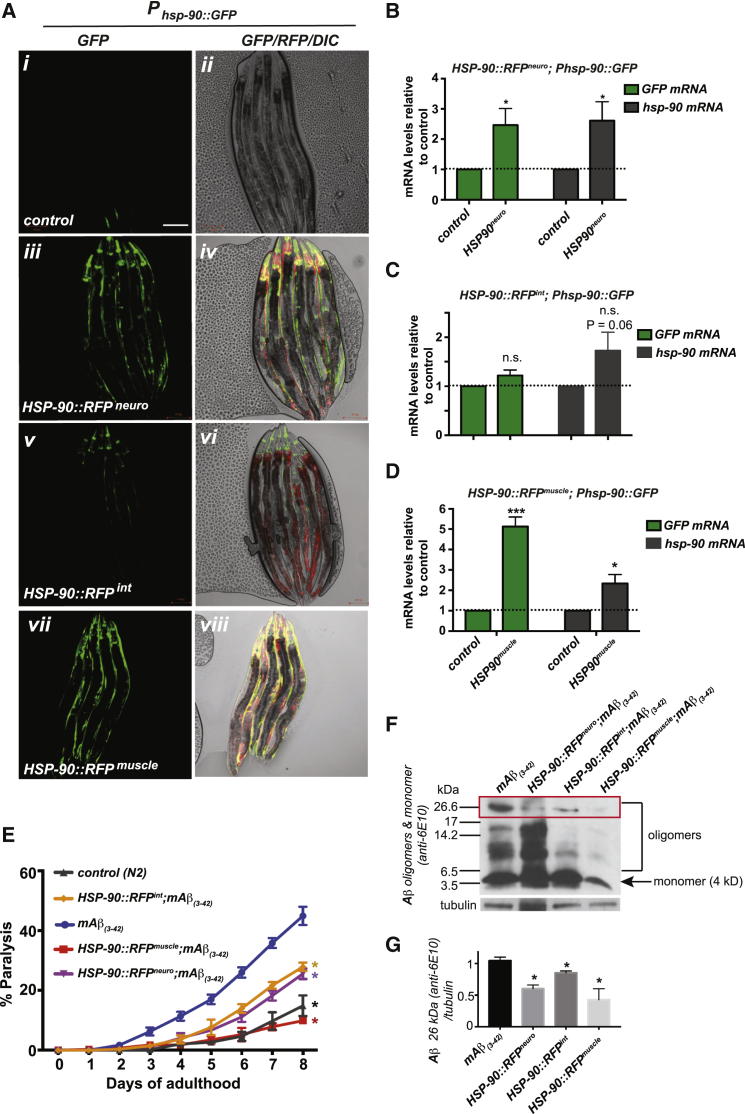
Increased Expression of HSP-90 in the Neurons, Intestine, or Bodywall Muscle Activates TCS and Protects against Aβ(3-42) Protein Toxicity in Muscle(A–D) Phsp-90::GFP expression in control animals (i and ii), HSP-90::RFPneuro (iii and iv), HSP-90::RFPint (v and vi), or HSP-90::RFPmuscle (vii and viii) (A). Scale bar, 50 μm. GFP and hsp-90 mRNA levels in HSP-90::RFPneuro; Phsp-90::GFP (B), HSP-90::RFPint; Phsp-90::GFP (C), and HSP-90::RFPmuscle; Phsp-90::GFP (D) relative to control animals expressing Phsp-90::GFP.(B–D) Bar graphs represent the mean of three independent experiments. Error bars represent ± SEM. ∗p < 0.05, ∗∗∗p < 0.001; ns, not significant.(E) Paralysis assays of C. elegans expressing Aβ(3-42) in the bodywall muscle (CL2006) compared to wild-type (N2) or HSP-90::RFPneuro;Aβ(3-42), HSP-90::RFPint;Aβ(3-42), or HSP-90::RFPmuscle;Aβ(3-42). Paralysis data represent SEM of 3 biological replicates (n = 100 animals). Statistical significance was determined by Wilcoxon matched-pairs signed-rank test. ∗p < 0.05.(F) Western blot analysis of amyloid beta monomeric and oligomeric amyloid beta expression in day 3 adult control animals (mAβ(3-42), HSP-90::RFPneuro;Aβ(3-42), HSP-90::RFPint;Aβ(3-42), or HSP-90::RFPmuscle;Aβ(3-42).(G) Quantification of oligomers (band at 26.6 kDa) in mAβ(3-42), compared with HSP-90::RFPneuro;Aβ(3-42), HSP-90::RFPint;Aβ(3-42), or HSP-90::RFPmuscle;Aβ(3-42). Data are expressed as mean density of the indicated band based from three independent experiments. Error bars represent SEM. One-way ANOVA; ∗p < 0.05.See also Figure S1.